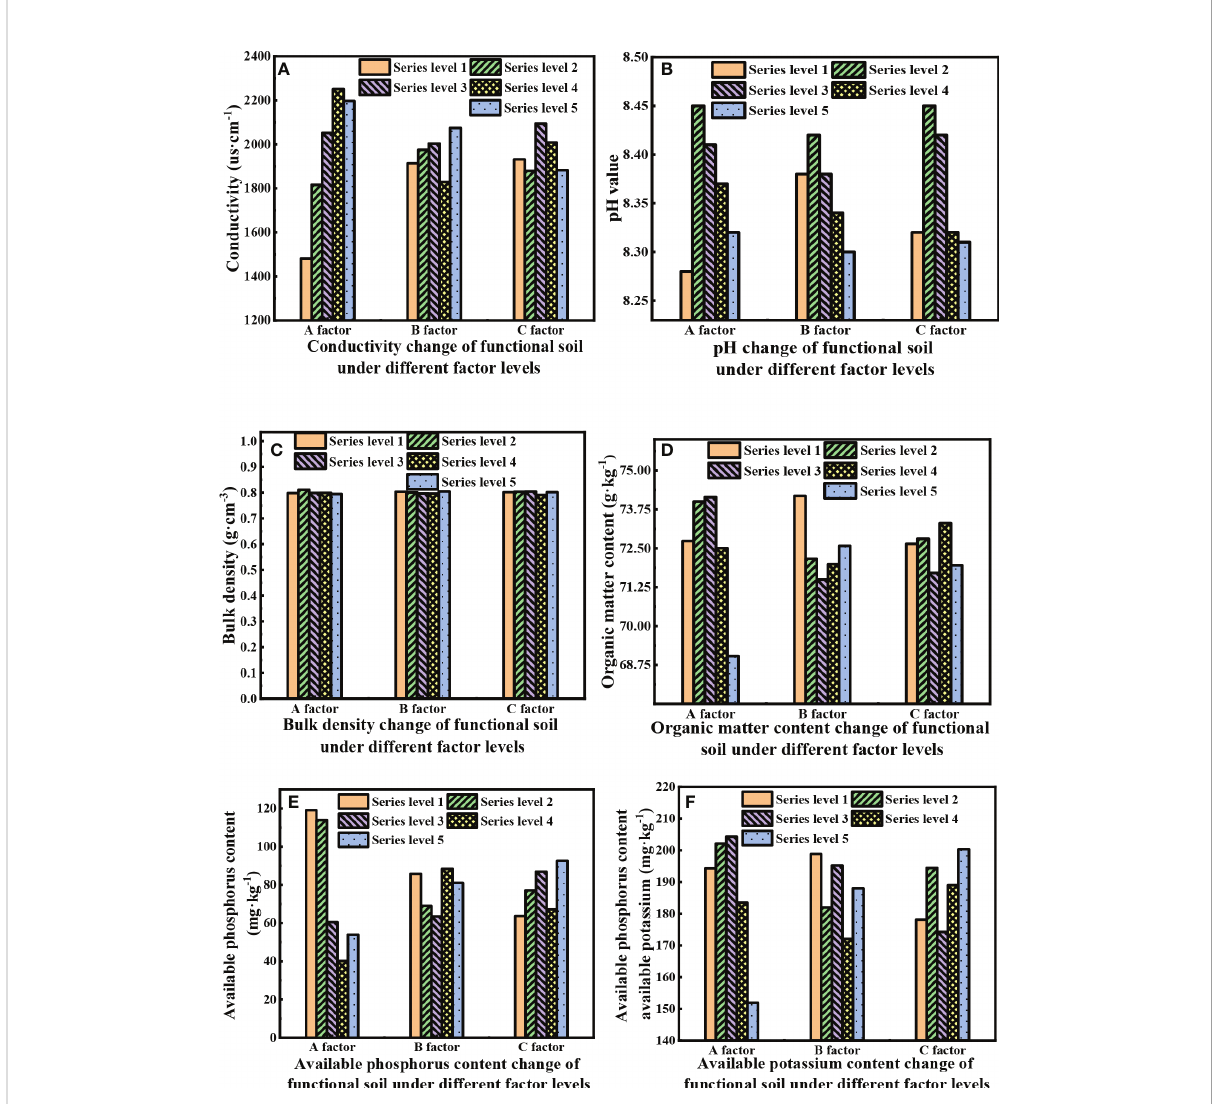
FIGURE 3 The physical and chemical characteristics of functional soils vary with the in fl uence of different